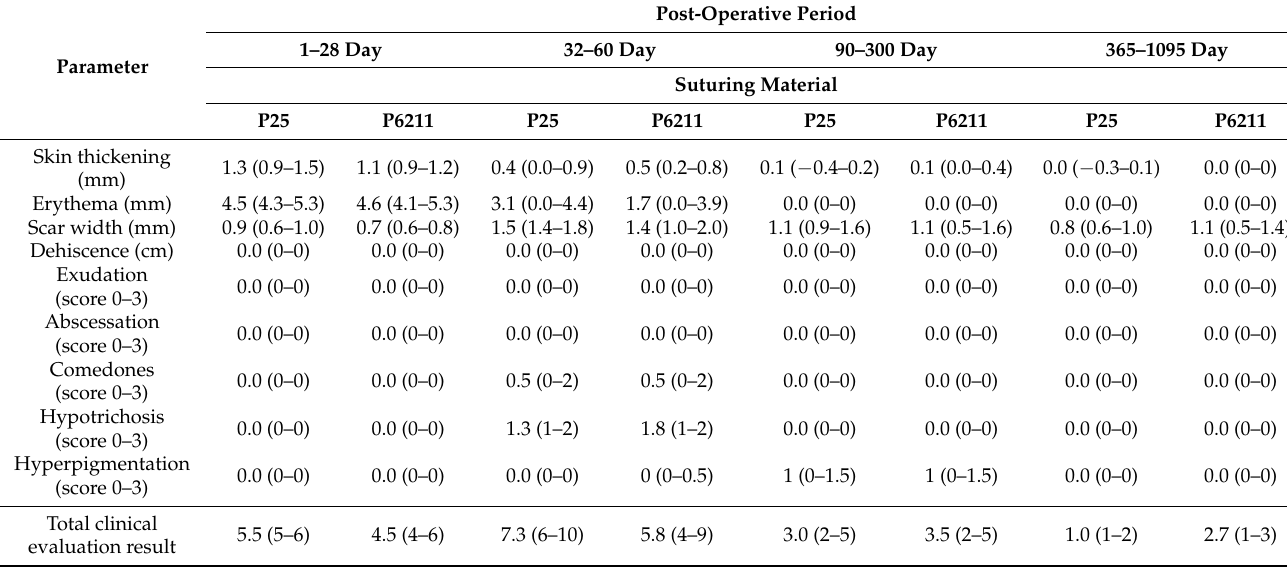
Table 2. Scores of clinical evaluation for each suturing material throughout the study (median values and interquartile length (in